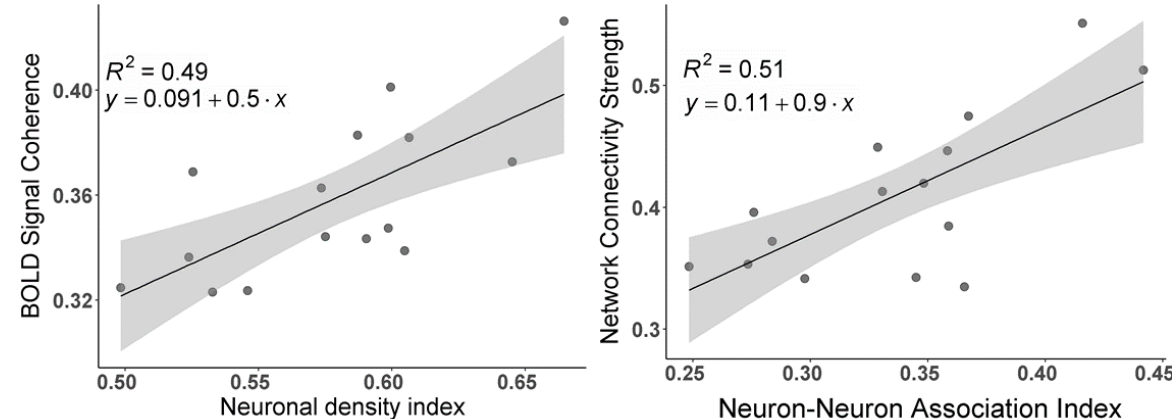
tural association between neurons Y (neuron – neuron). The curve shows the distribution of r-values calculated between Y (neuron – neuron) and randomly permuted FC 20,000 times. ( b ): The BOLD signal coherence vs. the Neuronal Density Index (NDI). The curve shows the distribution of r-values calculated between NDI and randomly permuted 10,000 times BOLD signal coherence. In both plots, the 99% percentiles of the distribution lines are marked by black dashed lines, while the r- values without permutation are marked as green lines and are well outside the black lines. The